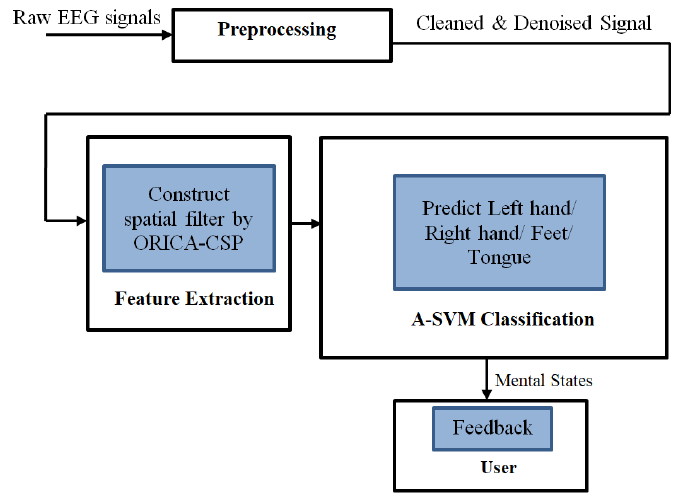
Figure 1. System